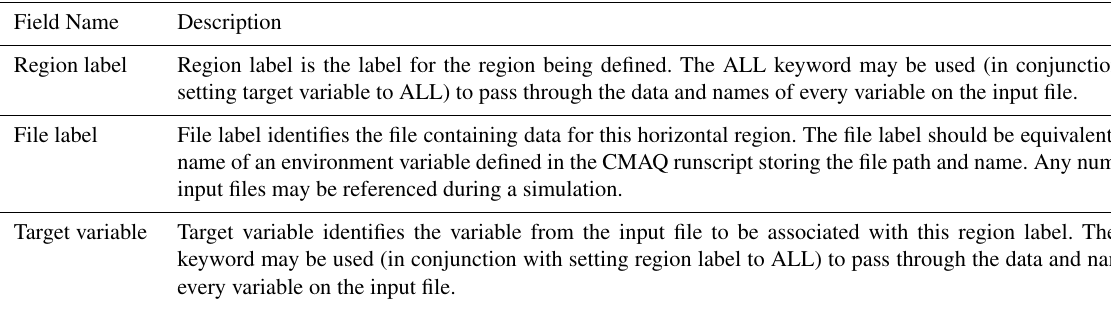
Table 3. Fields required for articulating region scaling rules in DESID.